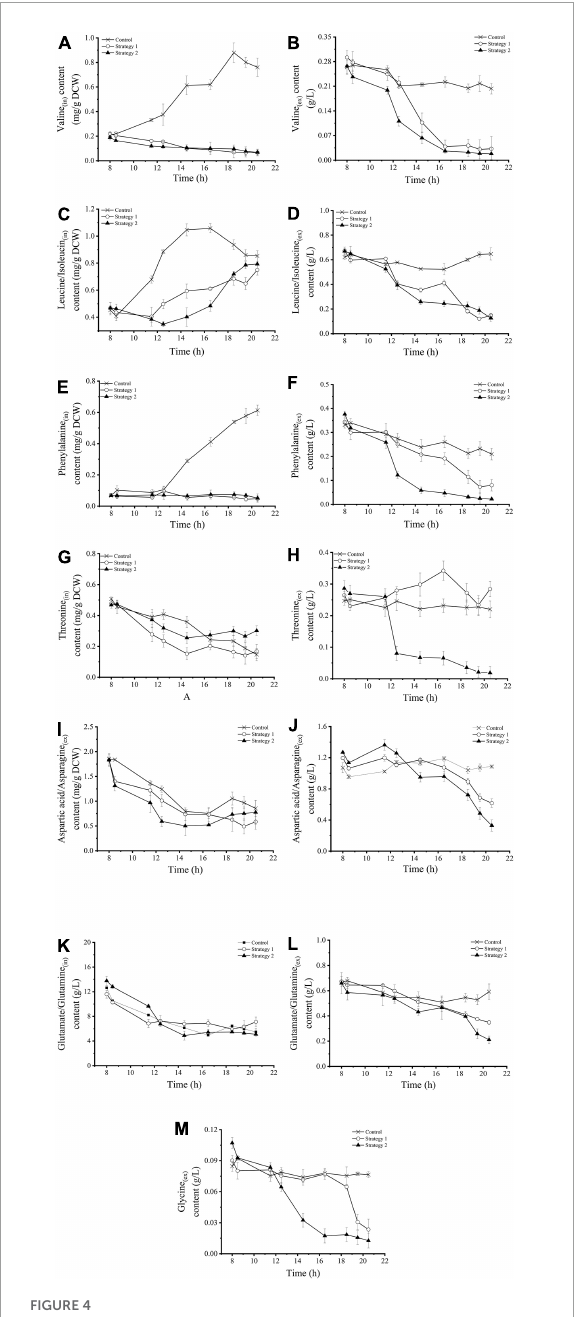
FIGURE4 (A–M) Changes in intracellular and extracellular amino acid concentrations in Z. rouxii using three fermentation regulation strategies. “in” stands for intracellular material, “ex” stands for extracellular